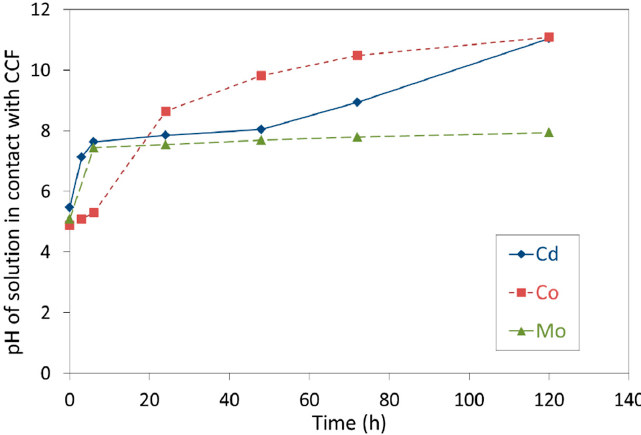
Figure 3. pH of supernatant solutions of Cd 2+ , Co 2+ and MoO 42 − ions in contact with CCF. Table 1. Kinetic parameters for the removal of Cd 2+ , Co 2+ and MoO 42 − from aqueous solution by crushed concrete fines.